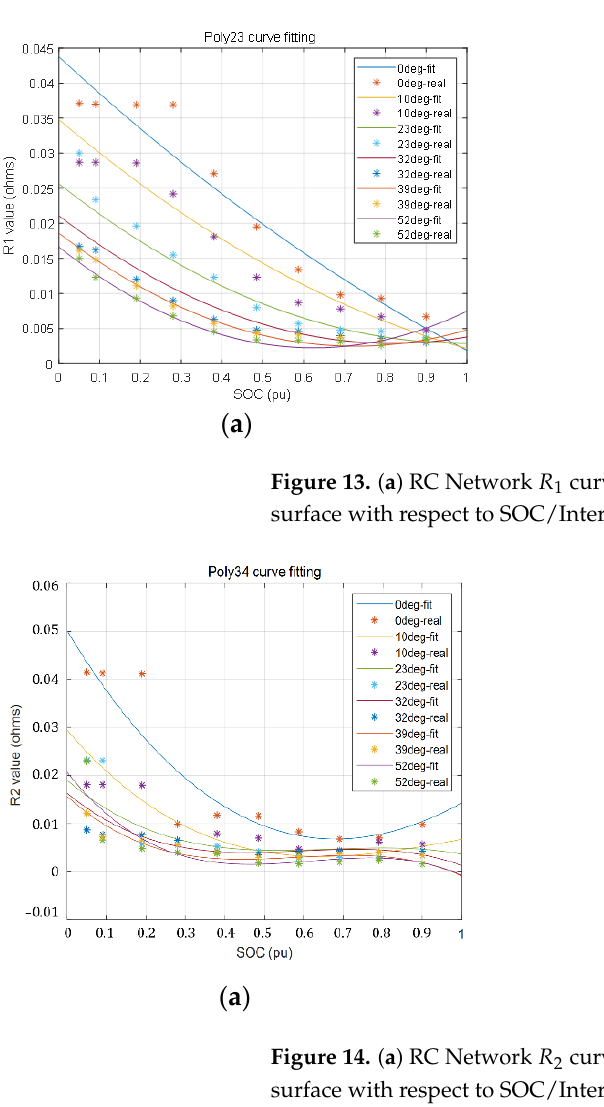
Figure 12. Battery internal resistance/temperature curve.